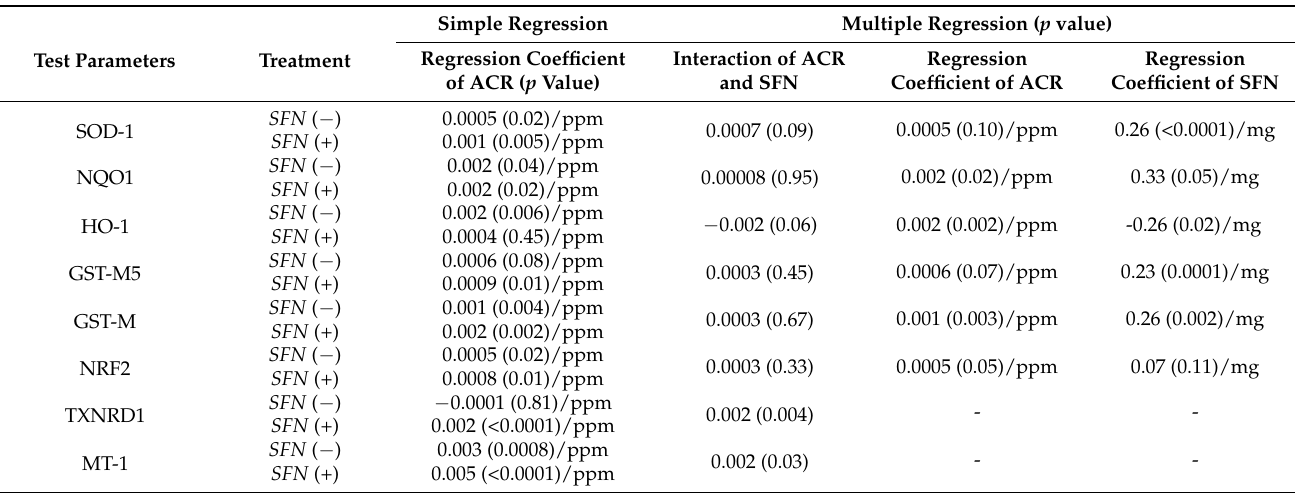
Table 3. Results of regression analysis of the effects of acrylamide and sulforaphane on mRNA expression of Nrf2- antioxidants in the cerebral cortex.